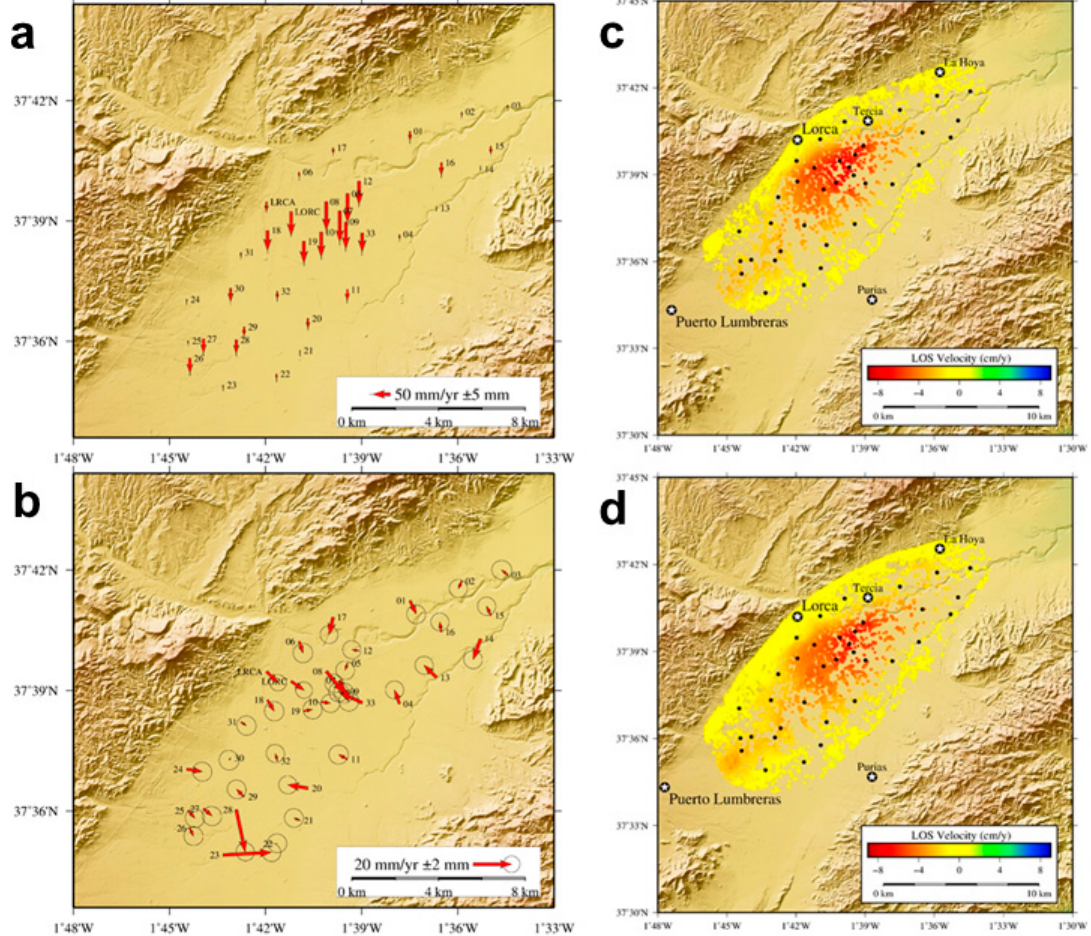
Figure 23. Displacement rates determined from GNSS observations. Results corresponding to the period November 2015–February 2017. ( a ) Annual vertical displacement rates, subsidence, measured with standard confidence bars. ( b ) Average annual horizontal displacements with standard confidence regions. Additional results are shown in the Supplementary Information from [5]. ( c ) and ( d ) show the results obtained from the A-DInSAR processing using CPT technique. Both geometries, ascending and descending, have been processed using a multilook window of 3 × 13 pixels (azimuth × range) which generates a square pixel of about 60 × 60 meters in ground resolution. Coherence method has been used for pixel selection coherence method. Results are shown for the period November 2015–February 2017. ( c ) Line of Sight (LOS) velocity values obtained for the ascending orbit. ( d ) LOS velocity values for the descending orbit. Black dots locate the GNSS stations. Modified from